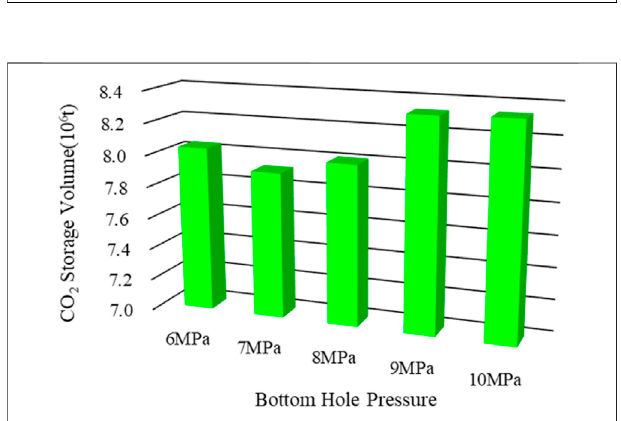
FIGURE 13 | Total CO 2 storage ratio under different bottom hole pressures.